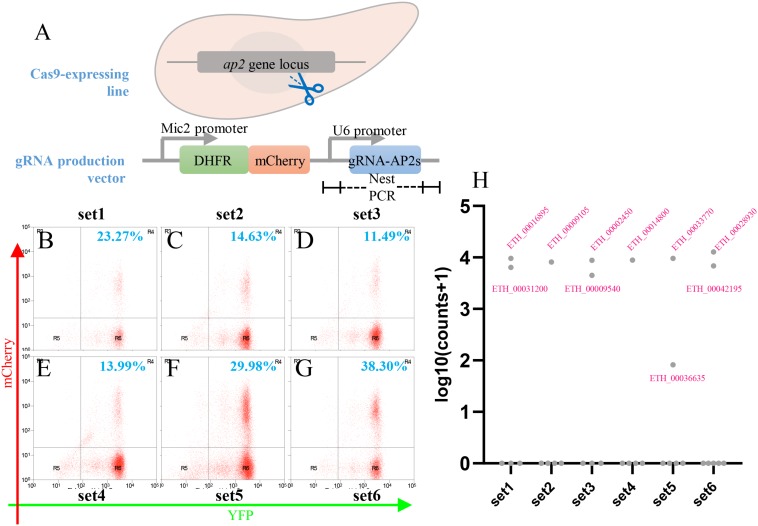
Cas9-mediated Etap2 family gene disruption. (A) Schematics showing the Etap2 family genes disrupted by transfection with gRNA-producing vectors. (B–G) Thirty-three Etap2 genes were screened by six sets of transfections, and the efficiency of each transfection was informed by flow cytometry analysis. (H) Log10 abundances of gRNAs remained in the positive oocysts determined by pooled sequencing of nest-PCR amplicons. Target gene IDs were indicated for their gRNAs presented in the sequencing reads.